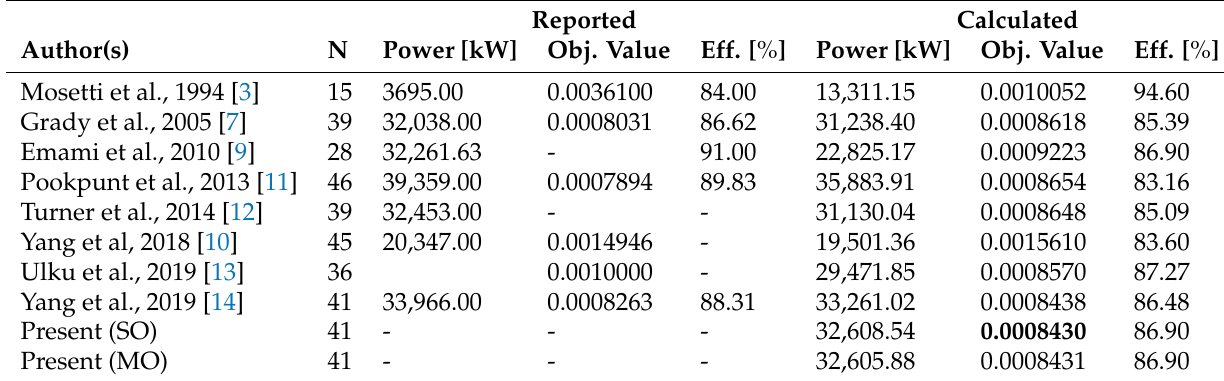
Table 6. Result comparison for case 4.